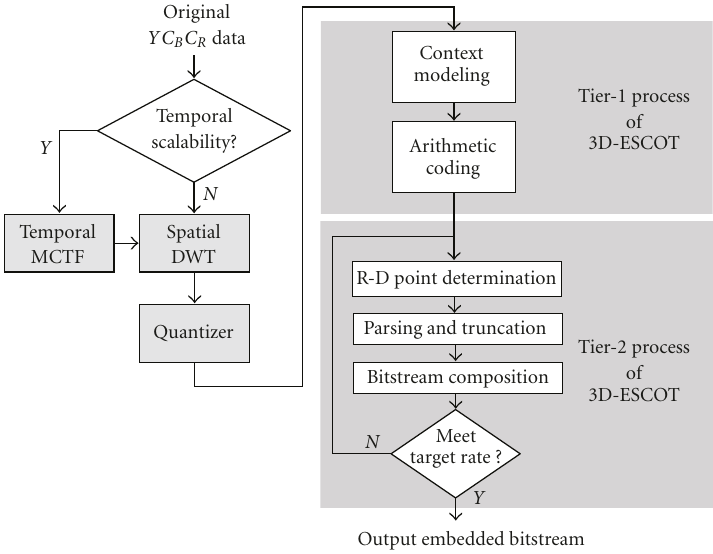
Figure 2: Wavelet video coding framework. The shaded areas illustrate the two-stage 3D-ESCOT rate adaptation